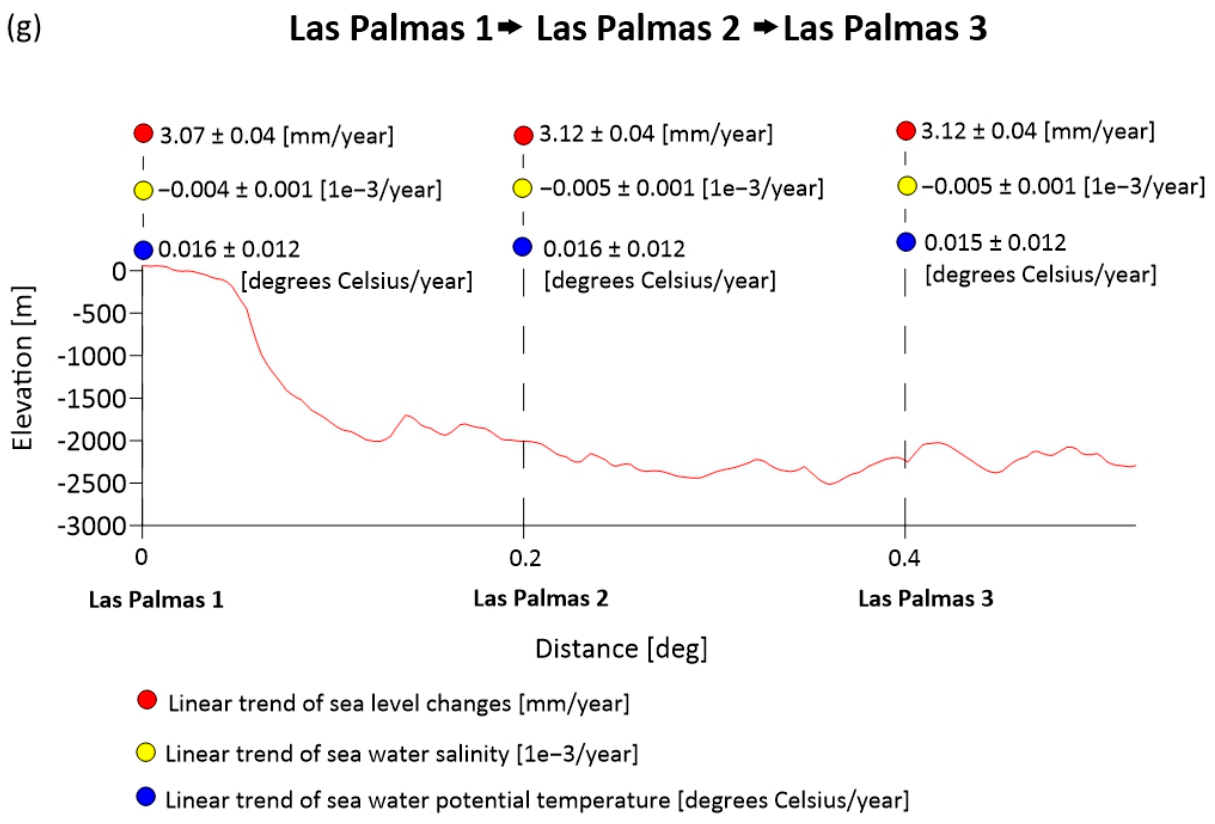
Figure 3. Generated seafloor models with estimated linear trends. The trend of sea level changes is visualized by red dots. The trend of sea water salinity is visualized by yellow dots. The trend of sea water potential temperature is visualized by blue dots. Seabed elevation is visualized by the red line.